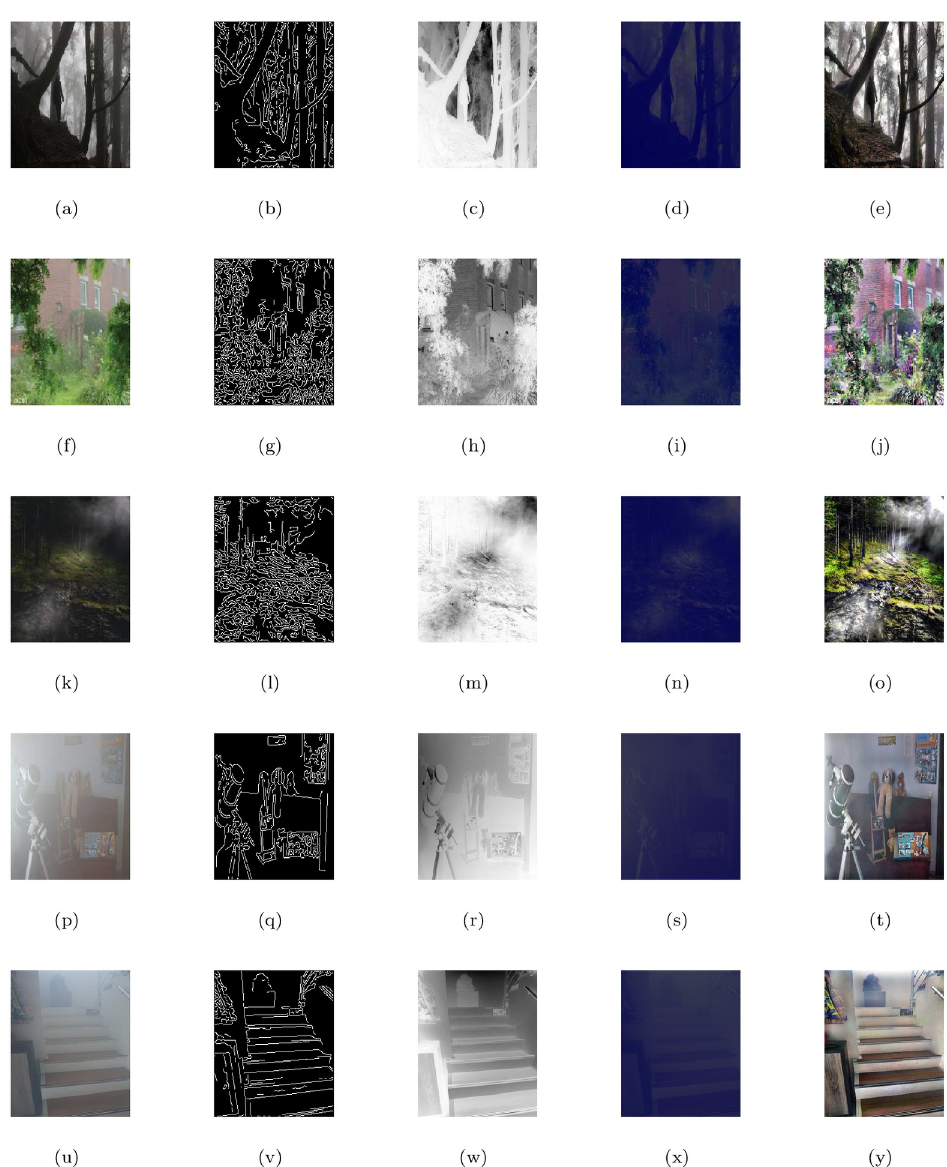
Fig 2. De-hazing outputs of the proposed model (M3). From left (L) to right (R), the original images (a,f,k,p,u), the corresponding visible edge maps (b,g,l,q,v), transmission maps (c,h,m,r,w), air-light maps (d,i,n,s,x) and final de- hazing results (e,j,o,t,y).